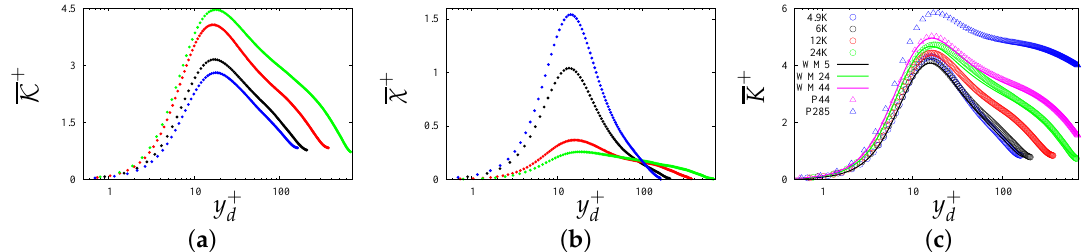
Figure 5. Flow in smooth pipes (SM): profiles of ( a ) incoherent turbulence kinetic energy ( K ), ( b ) coherent kinetic energy ( χ ), and ( c ) their sum ( K ), at the Reynolds numbers in the